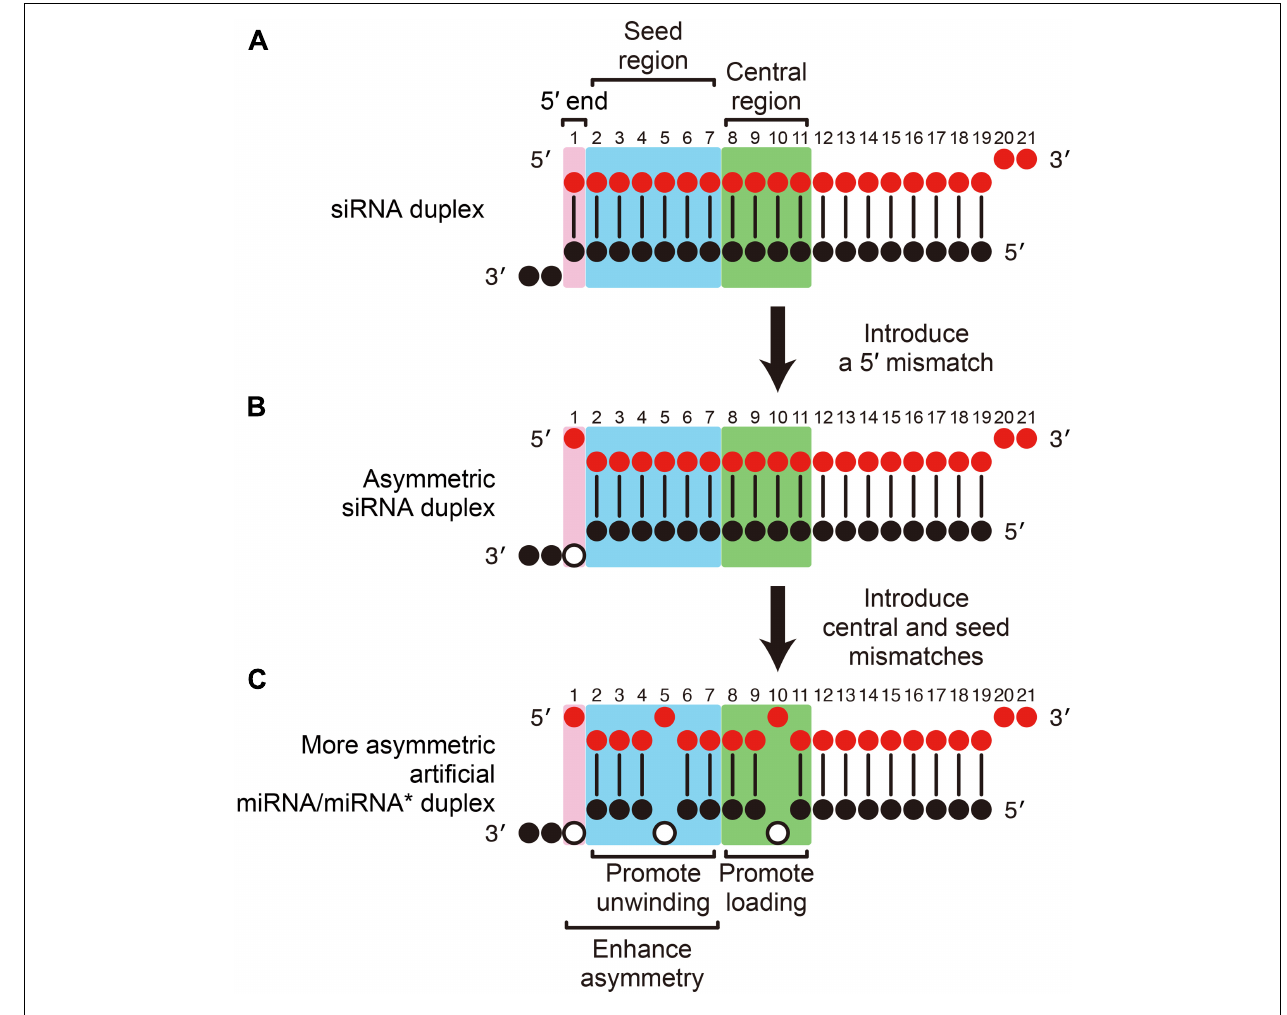
FIGURE 2 | Rational design of highly efficient, artificial miRNA/miRNA* duplexes. (A) A conventional siRNA. (B) A functionally asymmetric siRNA duplex is designed by introducing a mismatch at the 5 (cid:2) -end of the guide strand (pink). (C) An artificial miRNA/miRNA* duplex is designed from the asymmetric siRNA in B by appropriately introducing internal mismatches.